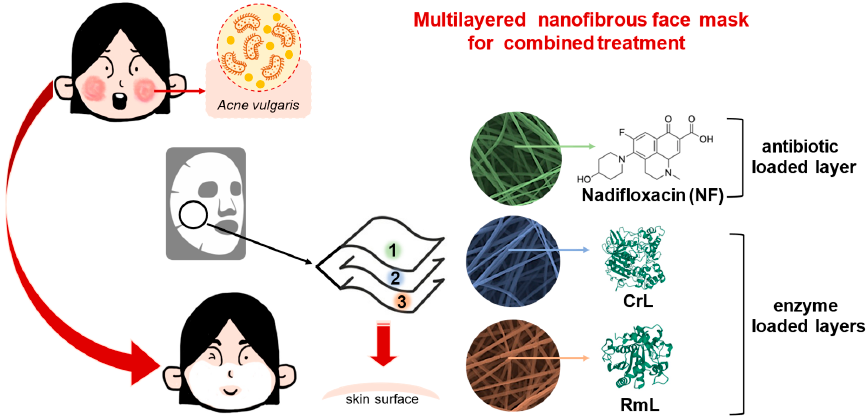
Figure 1. The composition of a multilayered nanofibrous face mask for combined treatment of acne vulgaris . The three-layered mask is built up of two enzyme loaded layers: lipase from Candida rugosa (CrL) and lipase from Rhizomucor miehei (RmL) formulated in polymeric (PVP or PLA) nanofibers and one layer with antibacterial effect: nadifloxacin (NF) formulated in polymeric nanofibers.